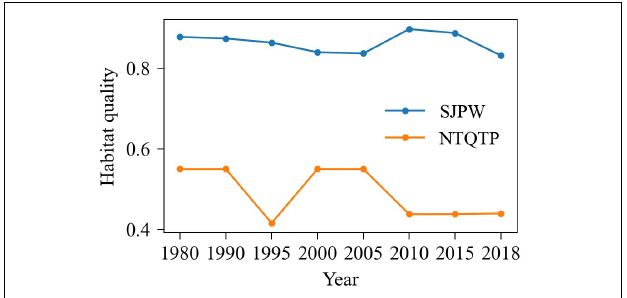
FIGURE 4 | Habitat quality changes of the core areas of national nature reserves in SJPW and NTQTP from 1980–2018.